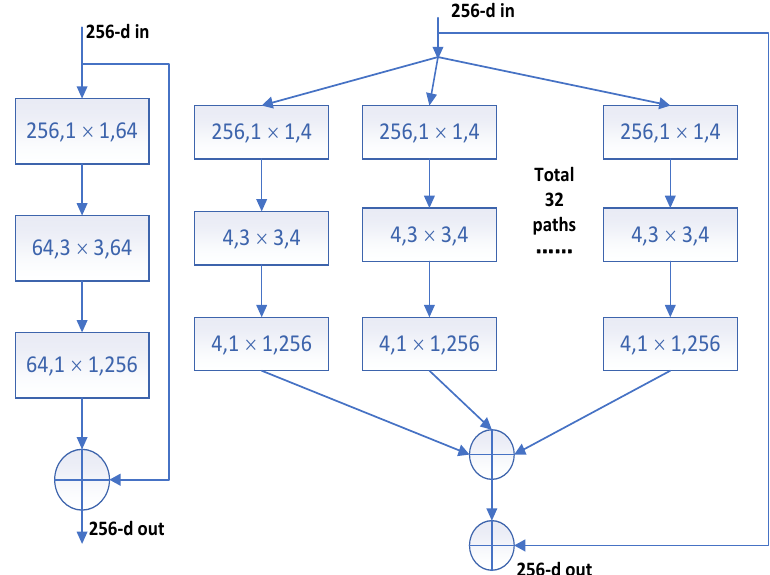
Figure 2. ResNet residual block ( left ) vs. ResNext residual block ( right ).